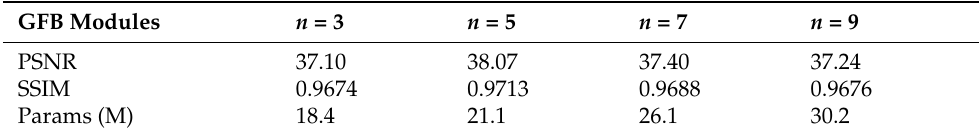
Table 5. Performance of the model with different numbers of GFBs.